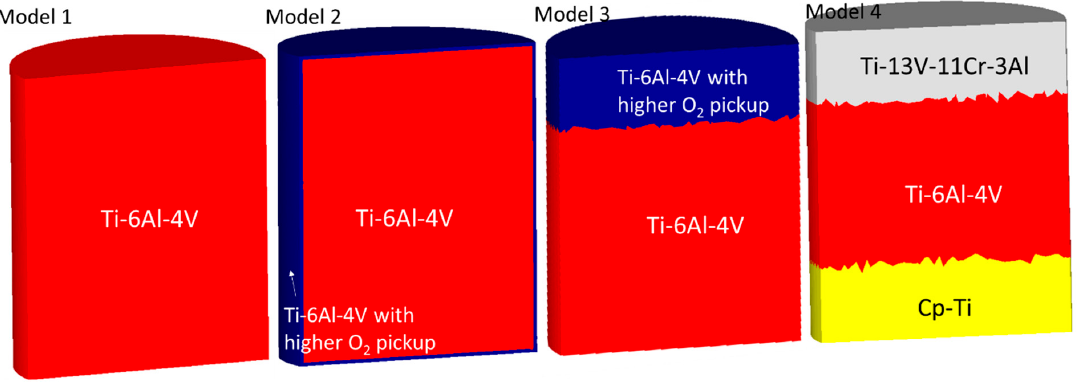
Figure 2. Partitioning of the cylindrical billet into different material regions to allow for study of location-specific properties throughout the forging deformation. Table 1. Initial billet